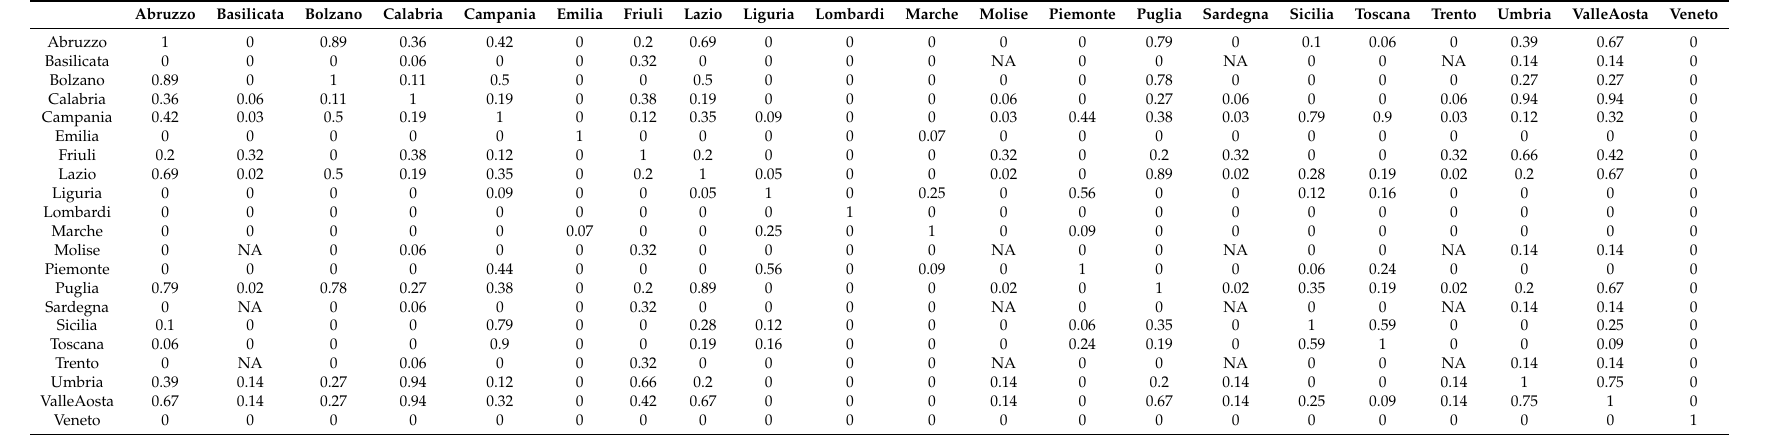
Table A26. Similarity values of Total Currently Positive network in the first